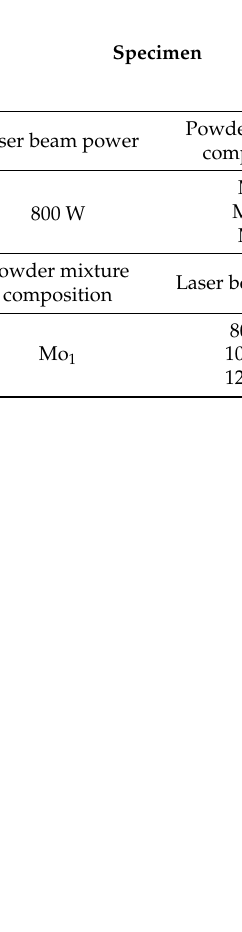
Table 1. Laser cladding parameters.